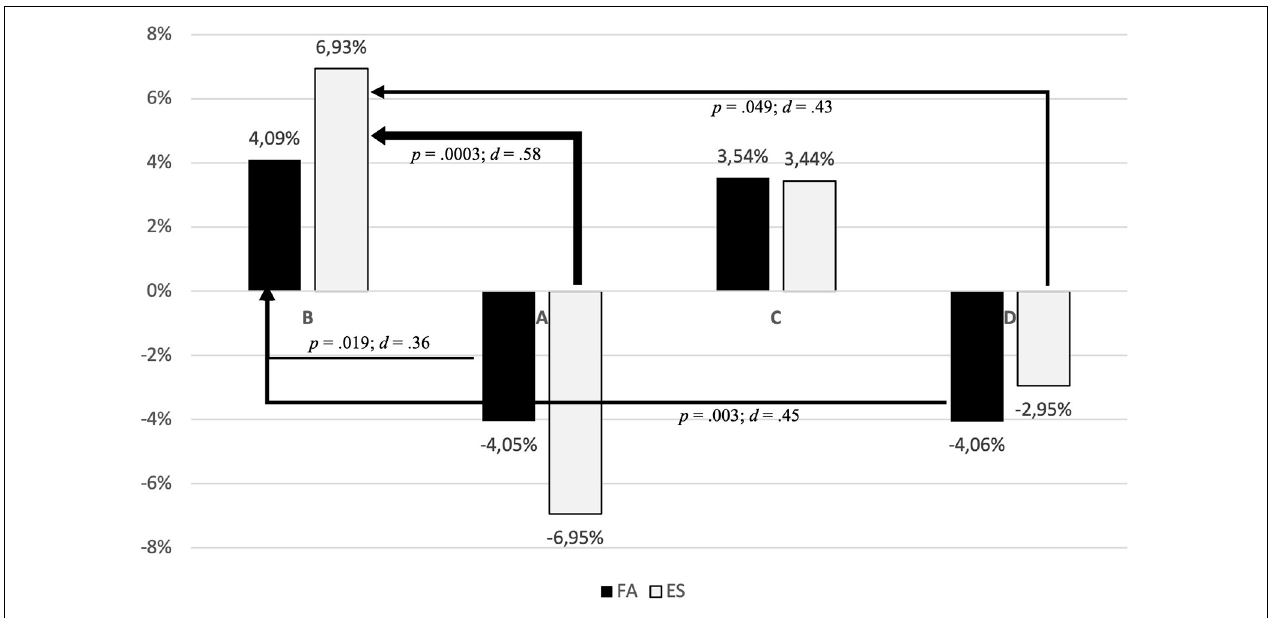
FIGURE 4 | Detailed shift of per-post attachment classification. TABLE 2 | Estimated coefficients of the generalized linear mixed model of the primary outcome MCAST